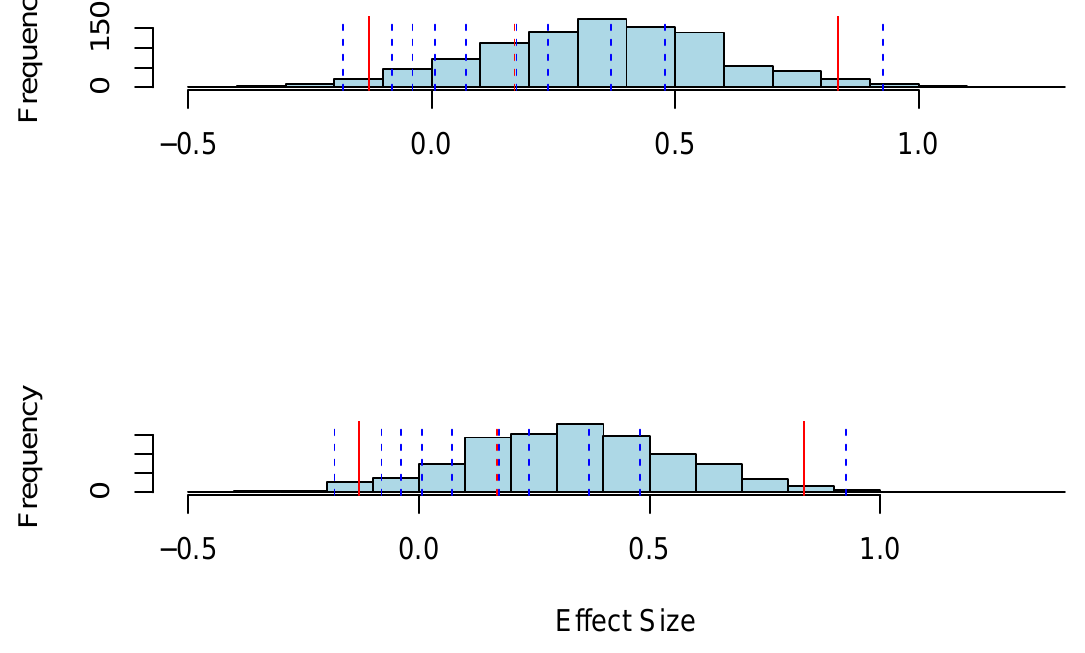
Figure 3. Histograms of simulation results. X-axis is size of bilingual decrement in terms of Cohen’s d (negative numbers indicate a numerical advantage for bilinguals). Solid red lines show the 95% confidence interval. Dashed lines show the measured effect sizes from studies included in the meta- analysis (the red dashed line is Hartshorne et al. 2018). Top: Using Giguere and Hoff’s (2020) criterion such that subjects began learning both languages before the age of 5. Bottom: Using the stronger criterion that both languages were learned from